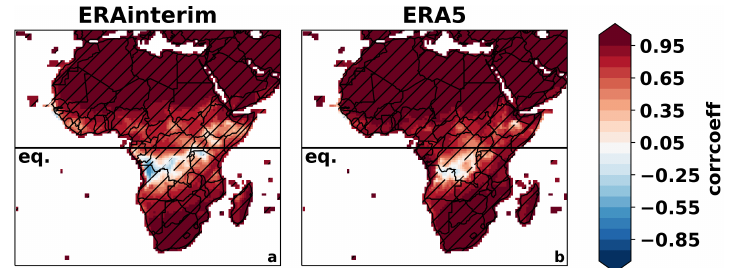
Figure 3. Observed near-surface temperature (CRU) averaged over 1981–2017 ( a ) and difference between ERA-interim ( b )/ERA5 ( c ) near-surface temperatures averaged over 1981–2017 and observed near-surface temperature averaged over 1981–2017. Hatching represents regions where differences are statistically significant at the 1% level.